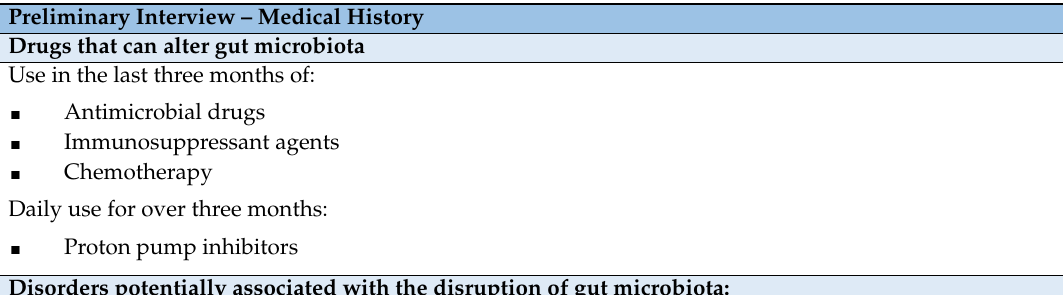
Table 1. Preliminary interview to select